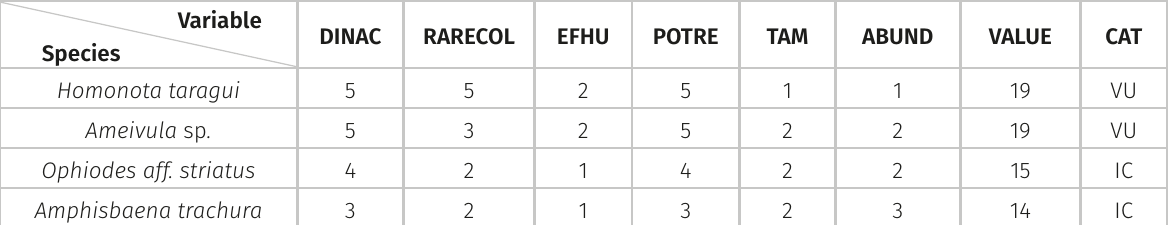
Table II. Values assigned to taxa for each variable described in Giraudo et al. (2012b). Spanish acronyms: National distribution (DINAC), Ecological rarity (RARECOL), Human effects (EFHU), Reproductive potential (POTRE), Size (TAM), Abundance (ABUND), Conservation status (CAT), Vulnerable (VU), Insufficiently Known (IC).